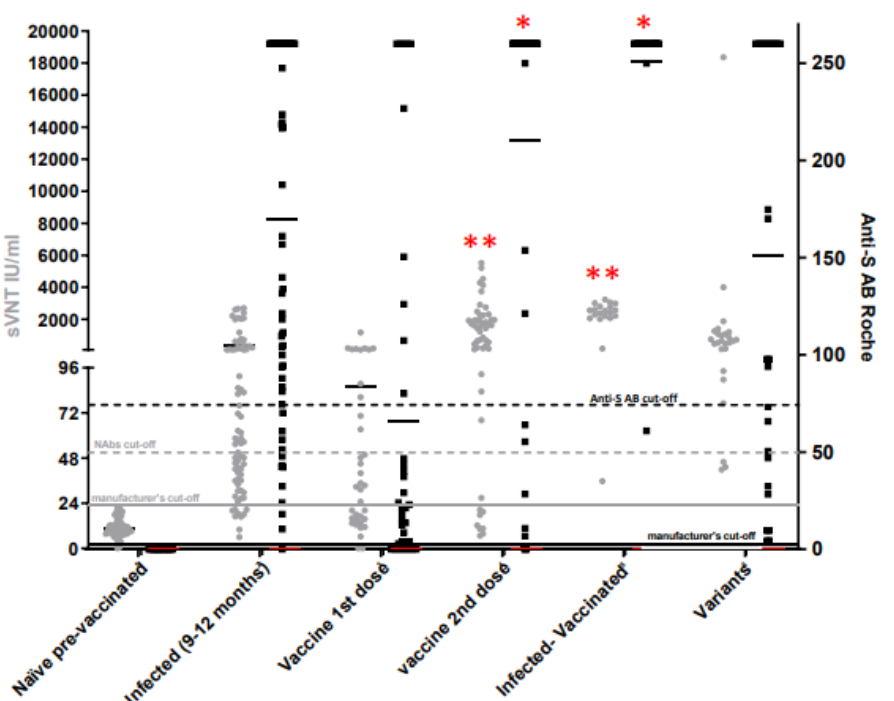
Figure 4. Anti-S eCLIA (black dots) vs. sVNT (grey dots) results. Cut-offs provided by manufacturers and cut-offs established with cVNTs are represented in full and dotted lines, respectively. Means of titers for each population and each assay are represented by a dash (* p < 0.05; ** p < 0.01)